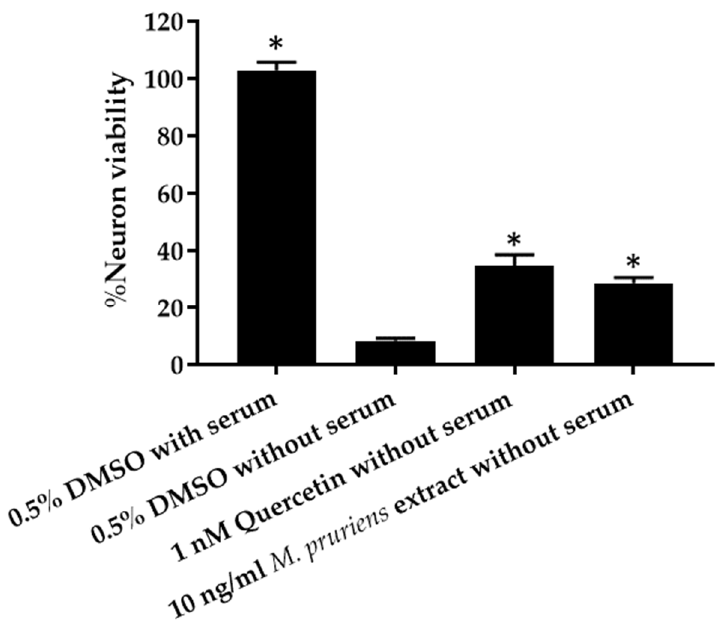
Figure 2. P19-derived neurons cell culture viability in 10 ng/mL Mucuna pruriens seed aqueous extract compared with the positive control (1 nM quercetin) and toxic condition (0.5% v/v DMSO in α -MEM without serum). * p < 0.05 compare with toxic condition (0.5% v/v DMSO in α -MEM without serum).